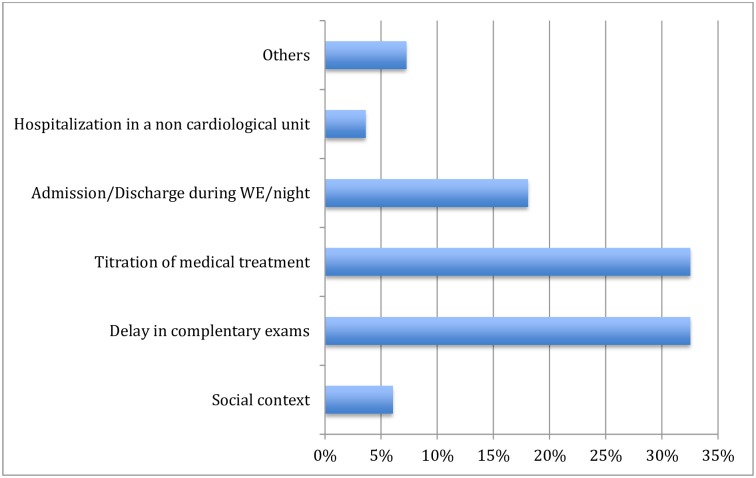
Documented reasons for prolongation of hospitalization in 83 patients with a Zwolle index score ≤ 3 points (at low risk of complications) and without clinical reasons.Abbreviatsions: WE, weekend.